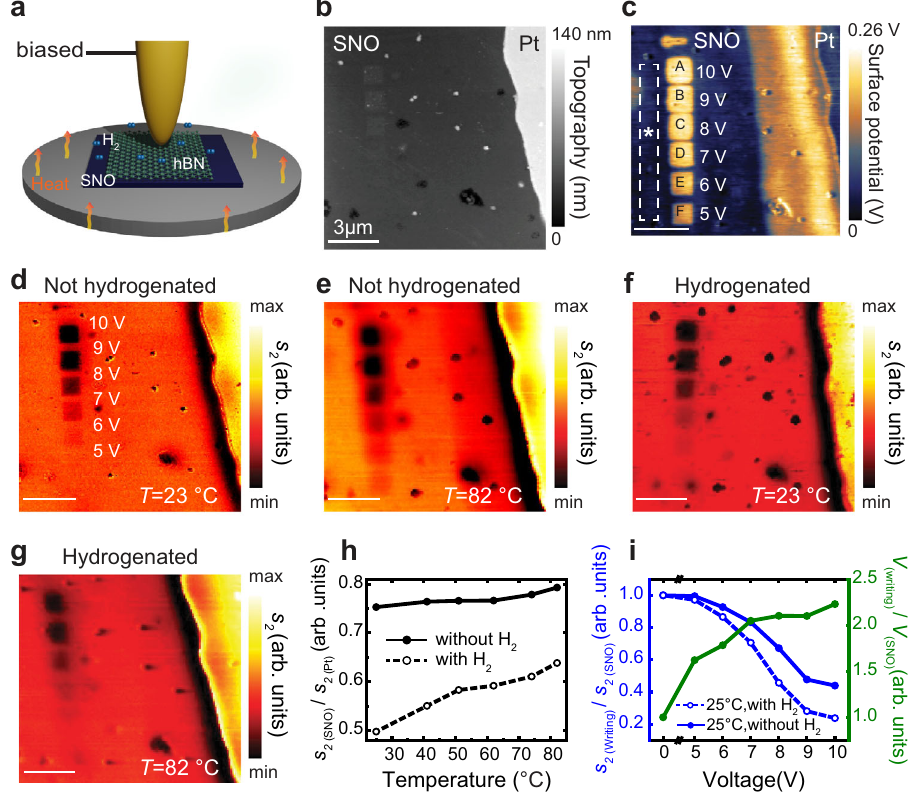
Fig. 1 | Tailoring the local conductivity of SNO (SmNiO 3 ). a Schematics of inte- grated s-SNOM (Scattering type Scanning Near- fi eld Optical Microscopy) and heating setup, in case of conductive writing tip is biased. b AFM (Atomic Force Microscopy) topography image of pristine SNO. c SKPM (Scanning Kelvin Probe Microscopy) surface potential image of conductive writing patterns on pristine SNO made by applying 5 – 10V potential at the c-AFM (Conductive AFM) tip, cor- responding infrared s-SNOM second harmonic near- fi eld amplitude s 2 images at d T =23°C (no H 2 exposure), e T =82°C (no H 2 exposure), f T =23°C, after